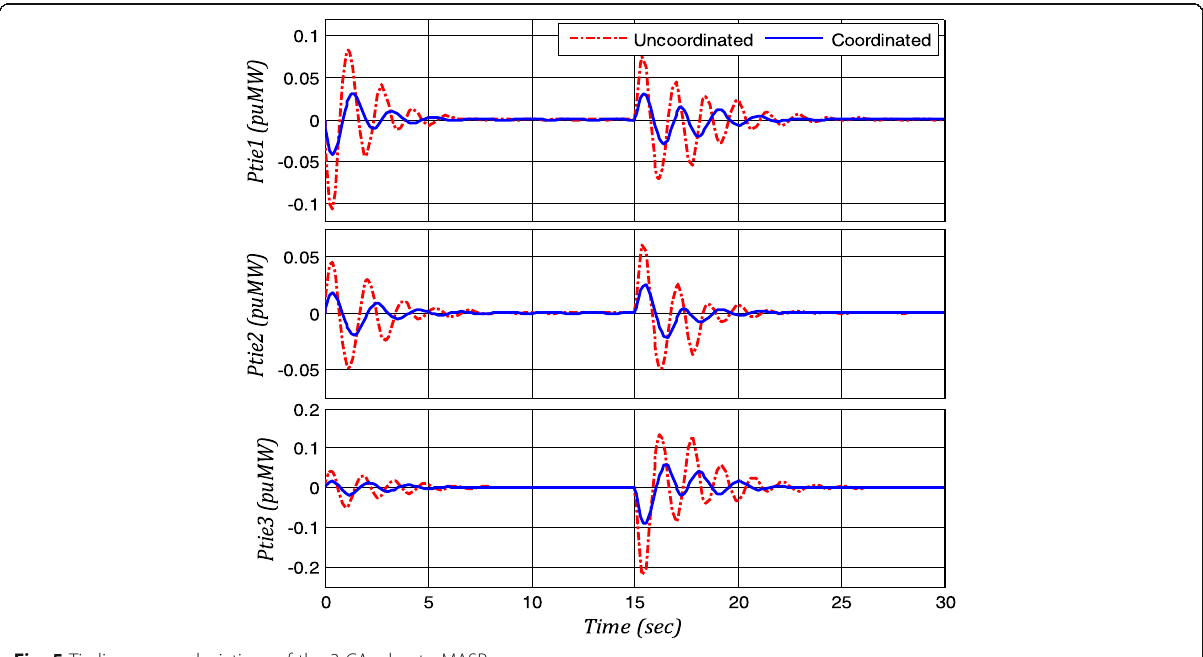
Fig. 5 Tie-line power deviations of the 3-CAs due to MASP